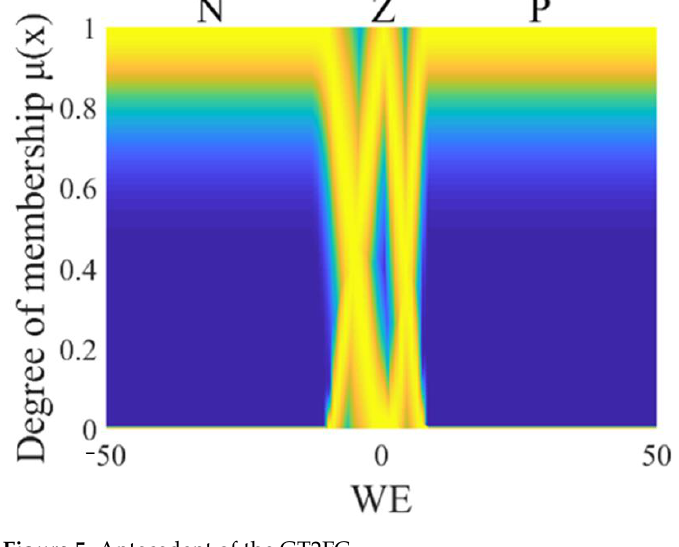
Figure 4. Antecedent of the GT2FC.